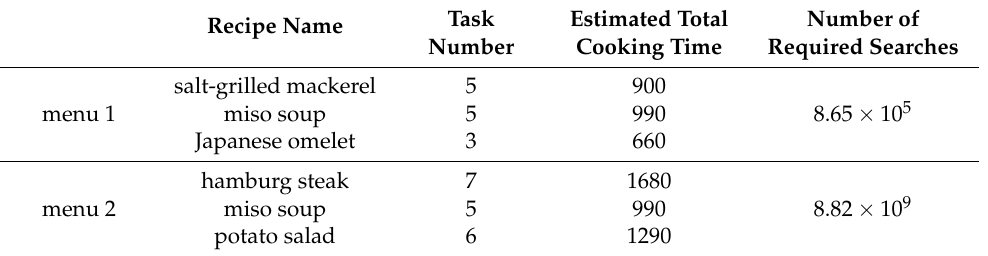
Table 2. Menu information.